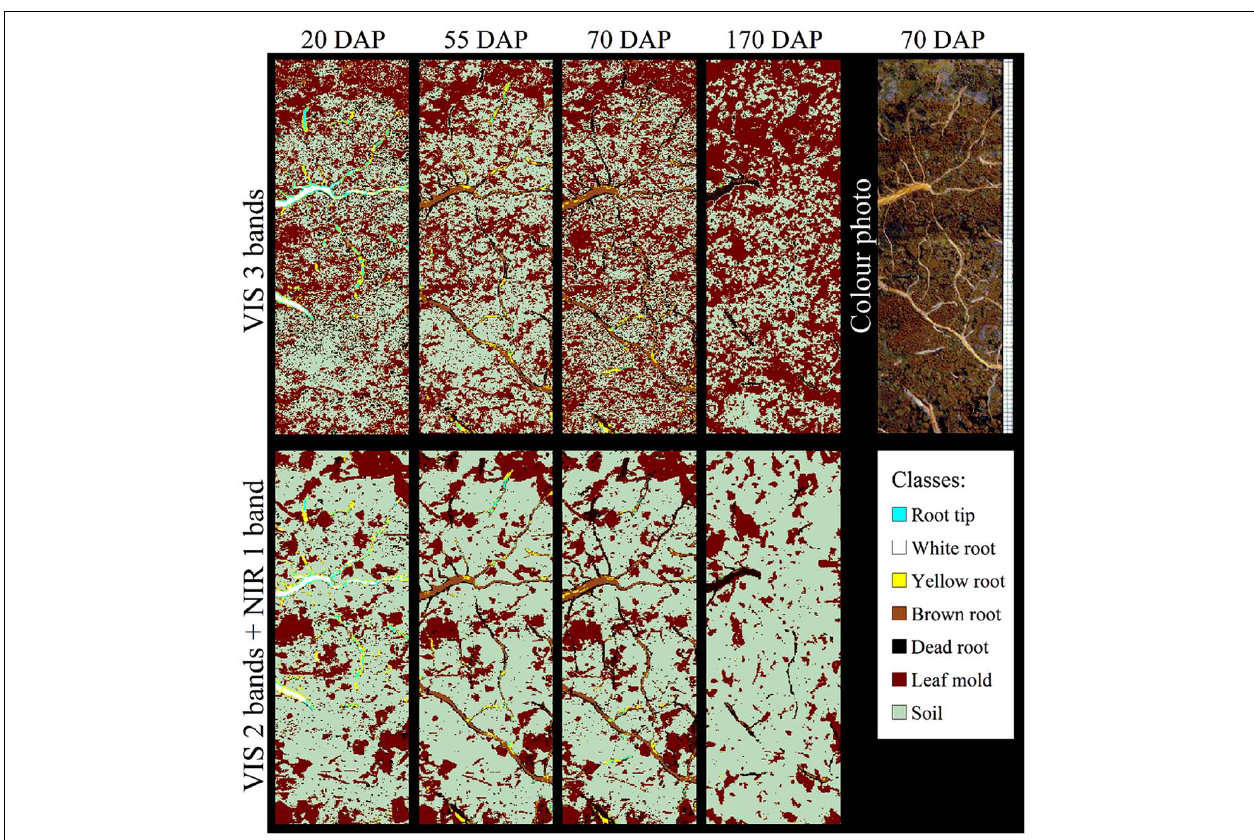
FIGURE 3 | Classification of Populus spp. rhizosphere components using different combinations of visible (VIS) and near infrared (NIR) wave bands to produce spectral reflectance images at days 20, 55, 70, and 170 after planting (DAP). Wavelengths of the three VIS bands (upper row) and the VIS–NIR bands (lower row) are 650, 550, and